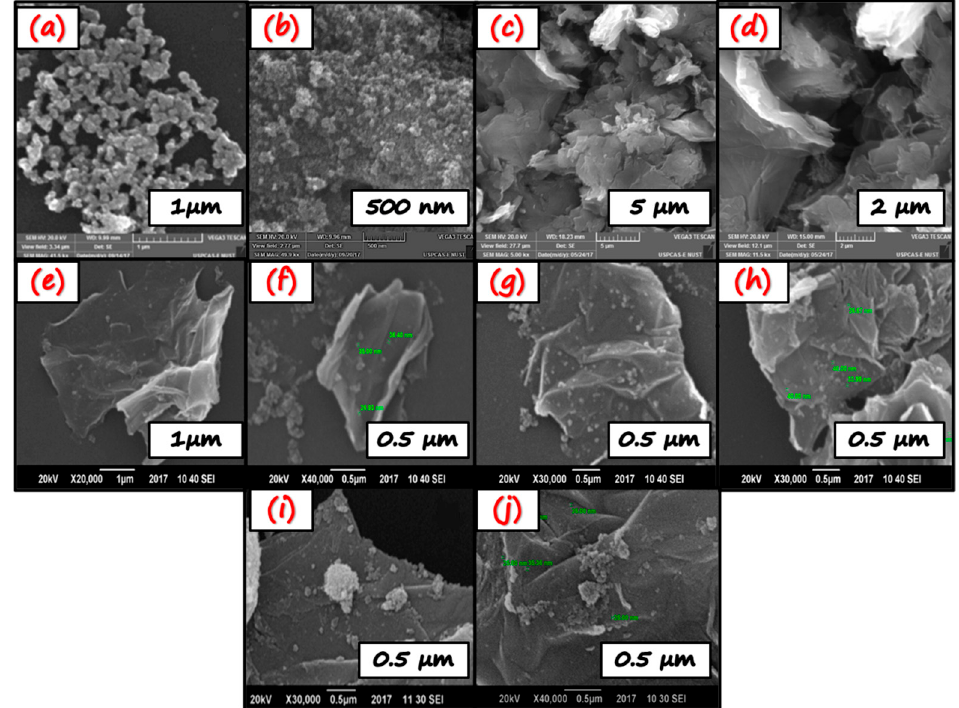
Figure 4. SEM analysis of TiO 2 ( a , b ), GO ( c , d ), NC-1 ( e , f ), NC-2 ( g , h ), NC-3 ( i , j ). EDX is utilized to find the elemental composition and purity of the sample. The pres- ence of every element in the sample is confirmed by its specific peak in the respective graph (Figure 5). The EDX results of TiO 2 (Figure 5a) clearly show the signals for titanium and oxygen. Figure 5b shows the signals of oxygen and carbon, which represents the GO sample. However, in nano-composites Figure 5c,d, the amount of titanium decreases while carbon and oxygen content increases from NC-1 to NC-3. This might be attributed to the increase in GO content from NC-1 to NC-3. Moreover, in all the EDX spectra, there exists no extra peak except the concerned elements. This shows the impurity-free synthesis of all the nano-photocatalysts. The atomic % of each element that forms a particular photocatalyst, for instance, the atomic % of Ti and O in TiO 2 , atomic % of C and O in GO, and the atomic % of Ti, C, and O in GO/TiO 2 nano-composites has been given in Table 2.